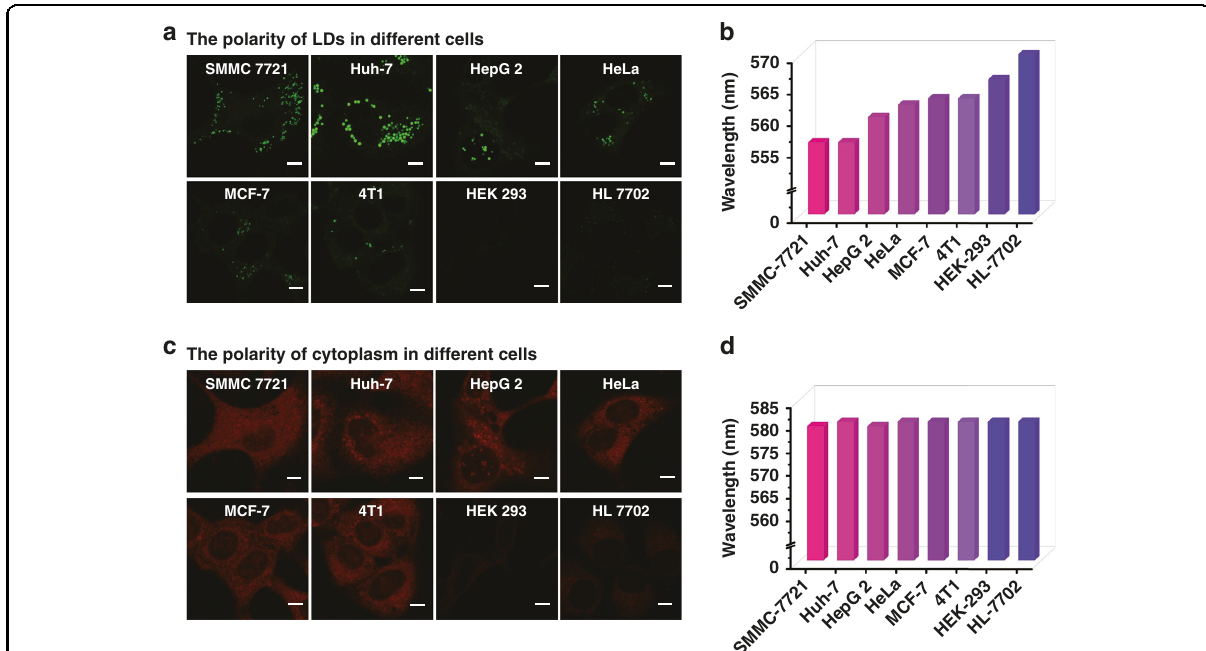
Fig. 5 Confocal images and in situ emission spectra of different cells. a Imaging of SMMC 7721 cells, Huh – 7 cells, HepG 2 cells, HeLa cells, MCF – 7 cells, 4T1 cells, HEK 293 cells, and HL 7702 cells, λ ex = 476 nm, λ em = 485 – 525 nm. b In situ emission spectrum of LDs in different cell lines with 50 μ g mL – 1 PS-CDs. c Imaging of SMMC 7721 cells, Huh – 7 cells, HepG 2 cells, HeLa cells, MCF – 7 cells, 4T1 cells, HEK 293 cells, and HL 7702 cells, λ ex = 476 nm, λ em = 585 – 625 nm. d In situ emission spectra of cytoplasm in different cell lines with 50 μ g mL – 1 PS-CDs. Scale bar in a , c : 10 μ m